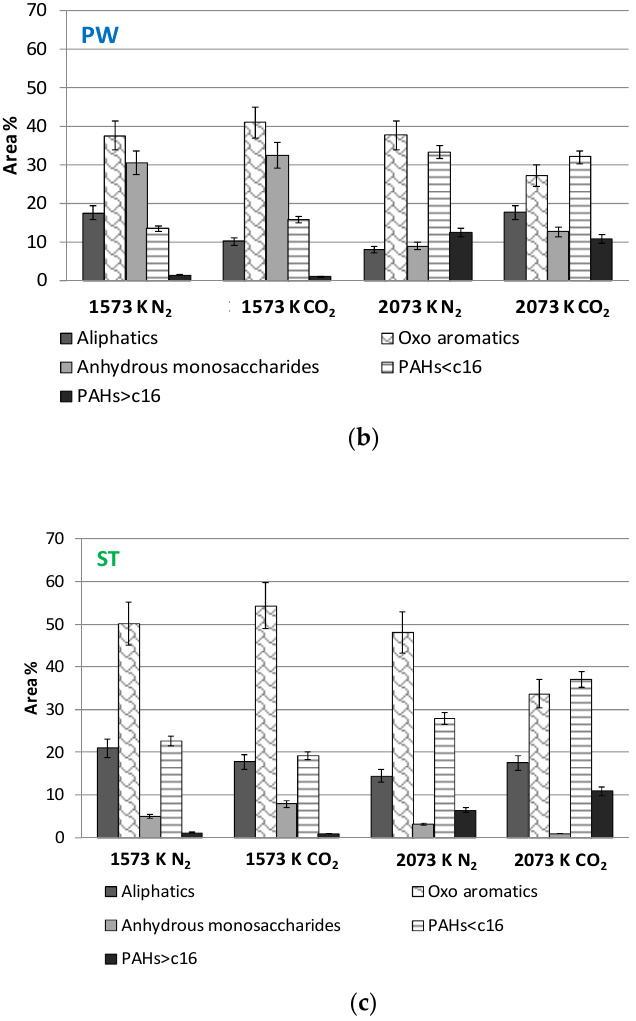
Figure 3. Gas Chromatography Mass Spectrometry (GC–MS) analysis on light tar samples of: ( a ) walnut shells (WS); ( b ) pinewood (PW); ( c ) straw (ST).